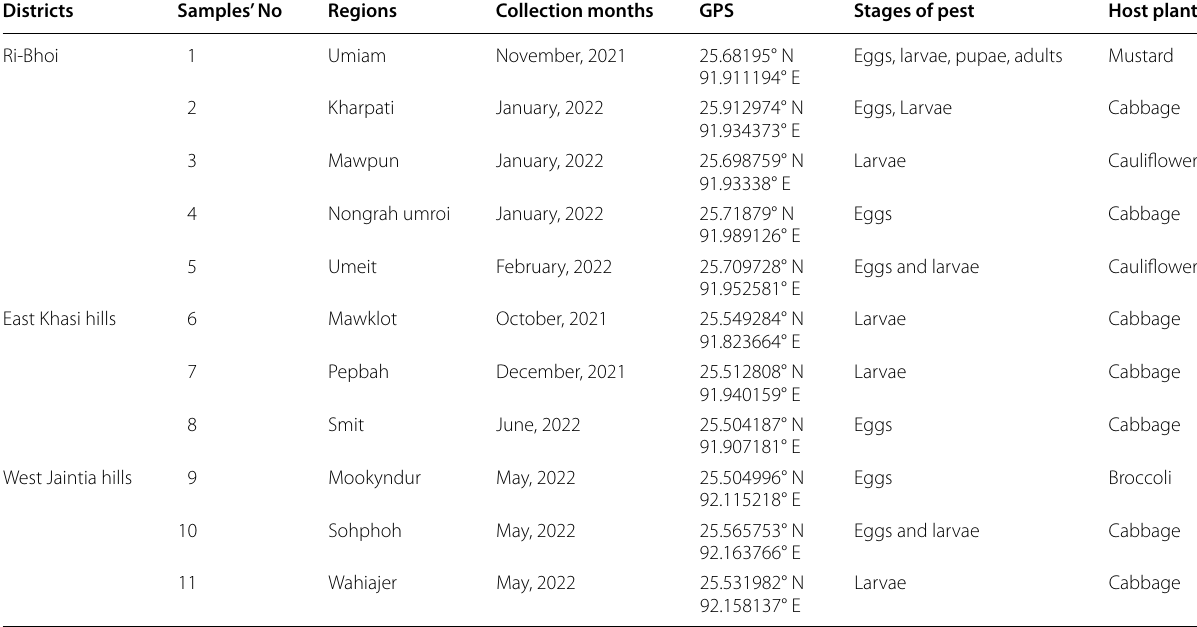
Districts Samples’ No Regions Collection months Ri-Bhoi